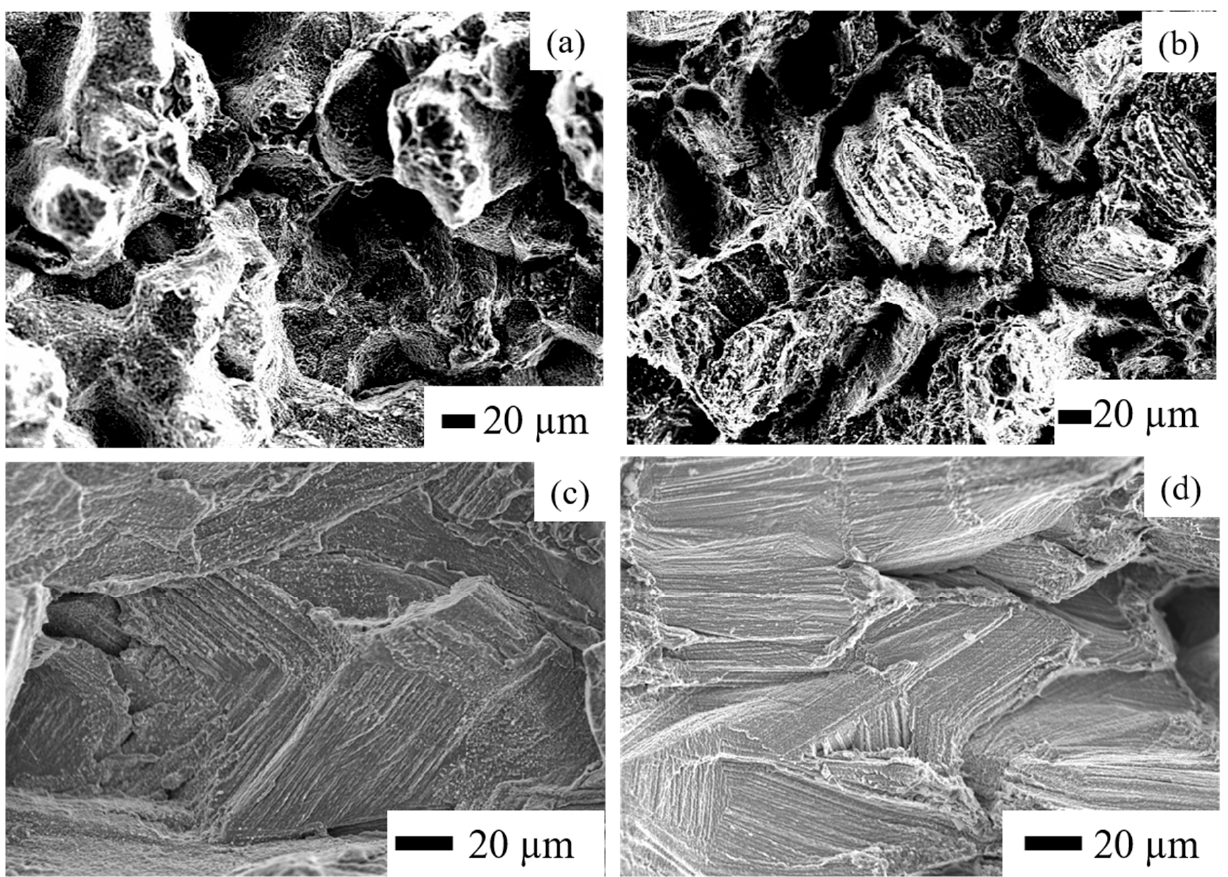
Figure 11. Fracture surfaces after creep tests at 900 °C under 80 MPa, vertical ( a ) HX and ( b ) HX-a as-built specimens, and horizontal ( c ) HX and ( d ) HX-a as-built specimens.